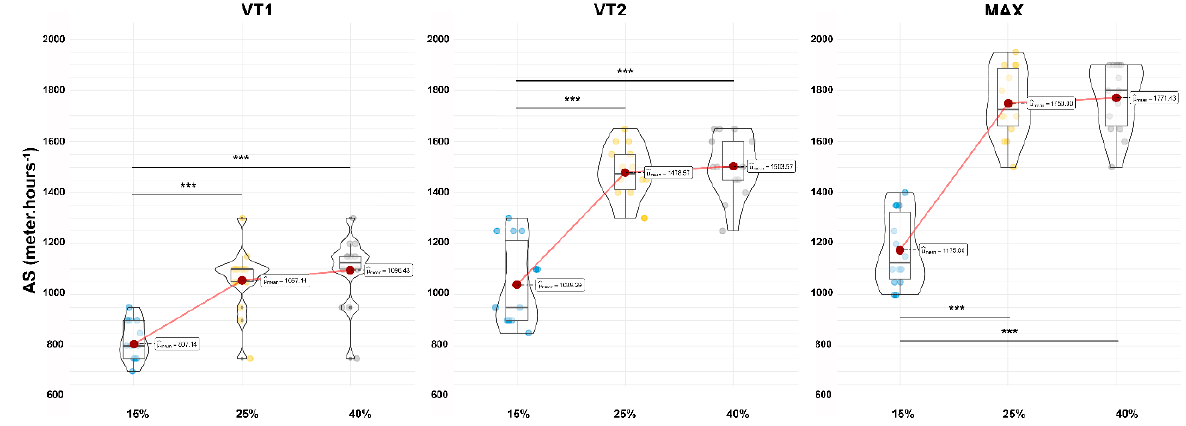
Figure 3. Violin plot of ascending speed (AS) at all positions (VT1, VT2 and MAX) for all slope conditions (15, 25 and 40%). Statistical differences observed were noted as follow; * p < 0.05, ** p < 0.01 and *** p < 0.001. Table 1. Mean and standard deviation of heart rate (HR), breathing frequency (BF), ventilation ( . VO 2 ) and ascending speed (AS) for each position; ventilatory thresholds (VT1 oxygen consumption ( and VT2) and at maximum (MAX) for 0, 15, 25, 40% gradient slope conditions. §, Ø and β indicate that value is significantly different than 0%, 15% and 25% gradient slope condition,